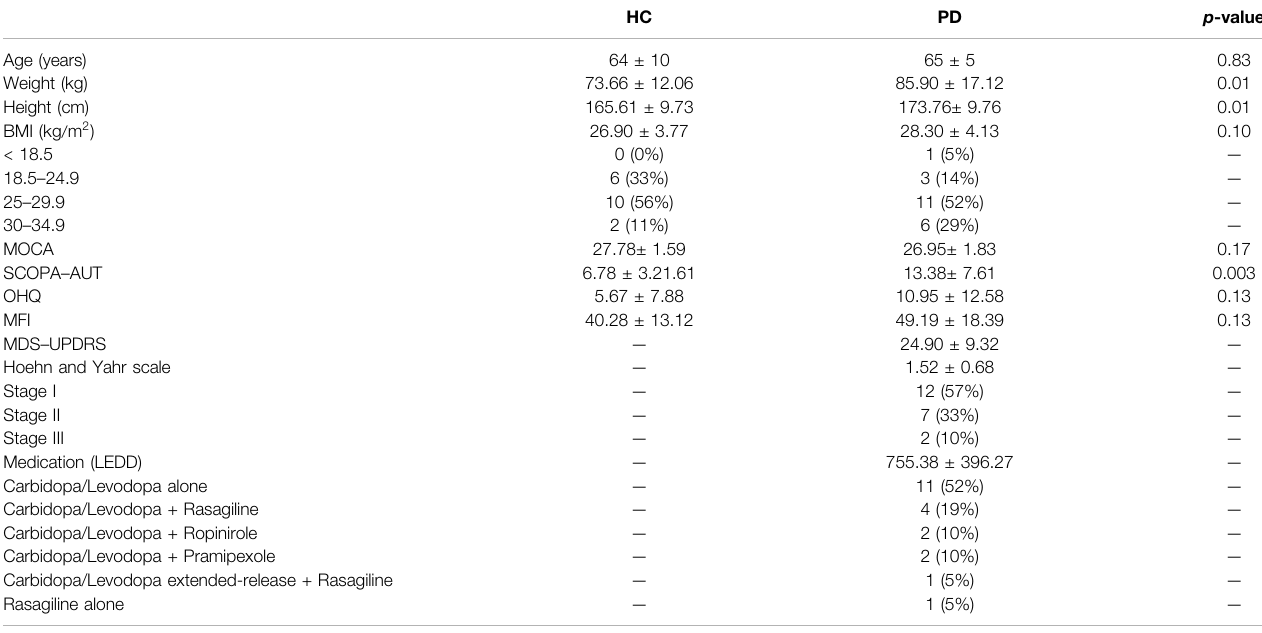
TABLE 1 | Characteristics of Parkinson ’ s disease patients and healthy controls considered in this study. Body mass index (BMI), Montreal Cognitive Assessment (MOCA), Scales for Outcomes in Parkinson ’ s disease – Autonomic Dysfunction (SCOPA – AUT), Orthostatic Hypotension Questionnaire (OHQ), Multidimensional Fatigue Inventory (MFI), Movement Disorder Society – Uni fi ed Parkinson ’ s Disease Rating Scale (MDS – UPDRS), Levodopa Equivalent Daily Dosage (LEDD). The table lists the Wilcoxon rank sum comparison p -value between Parkinson ’ s disease patients (PD) and healthy controls (HC).